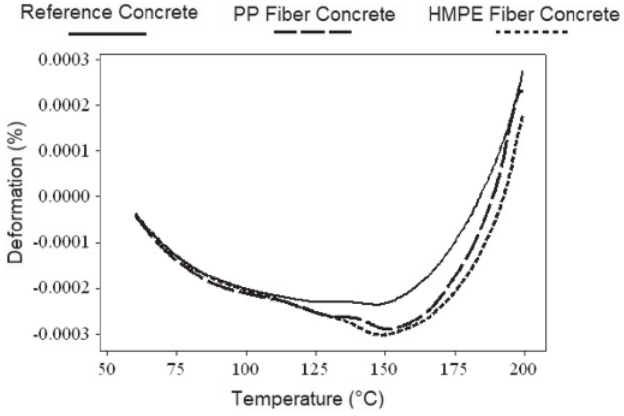
Thermal expansion of the reference concrete, concrete with polypropylene fiber and concrete with HMPE fiber